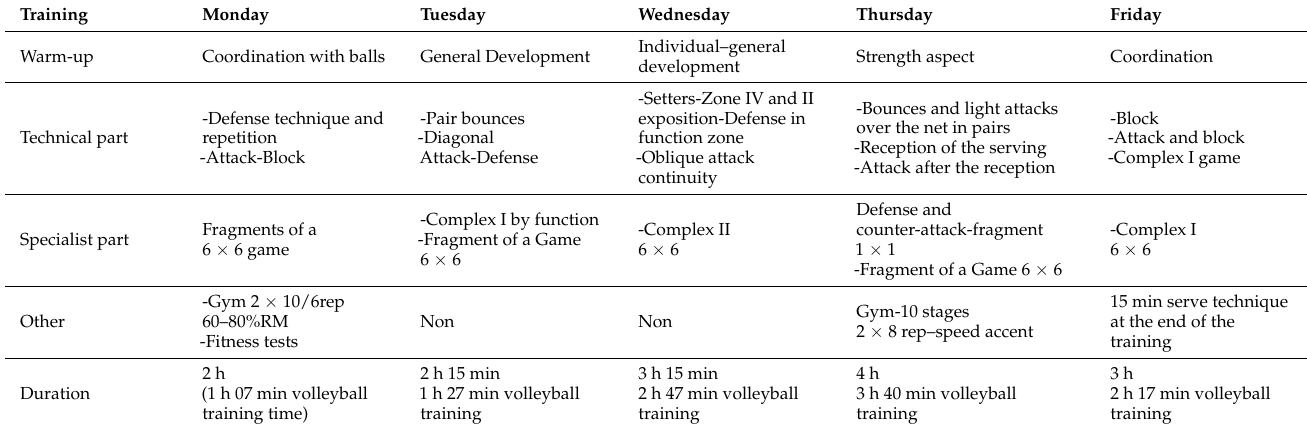
Table 1. Daily training